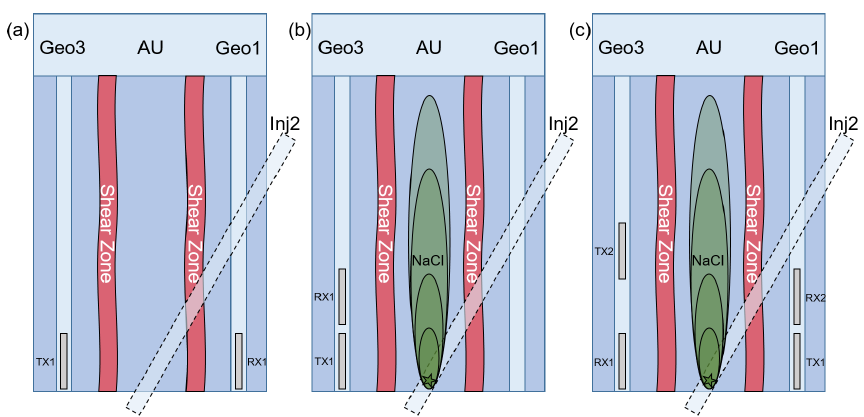
Figure 3. Schematic of the acquisition setups for the GPR surveys performed. (a) Setup for baseline data set without tracer injection. (b) Setup for tracer experiment 1 (reflection survey in borehole GEO3). (c) Setup for tracer experiment 2 (combined transmission and reflection survey).